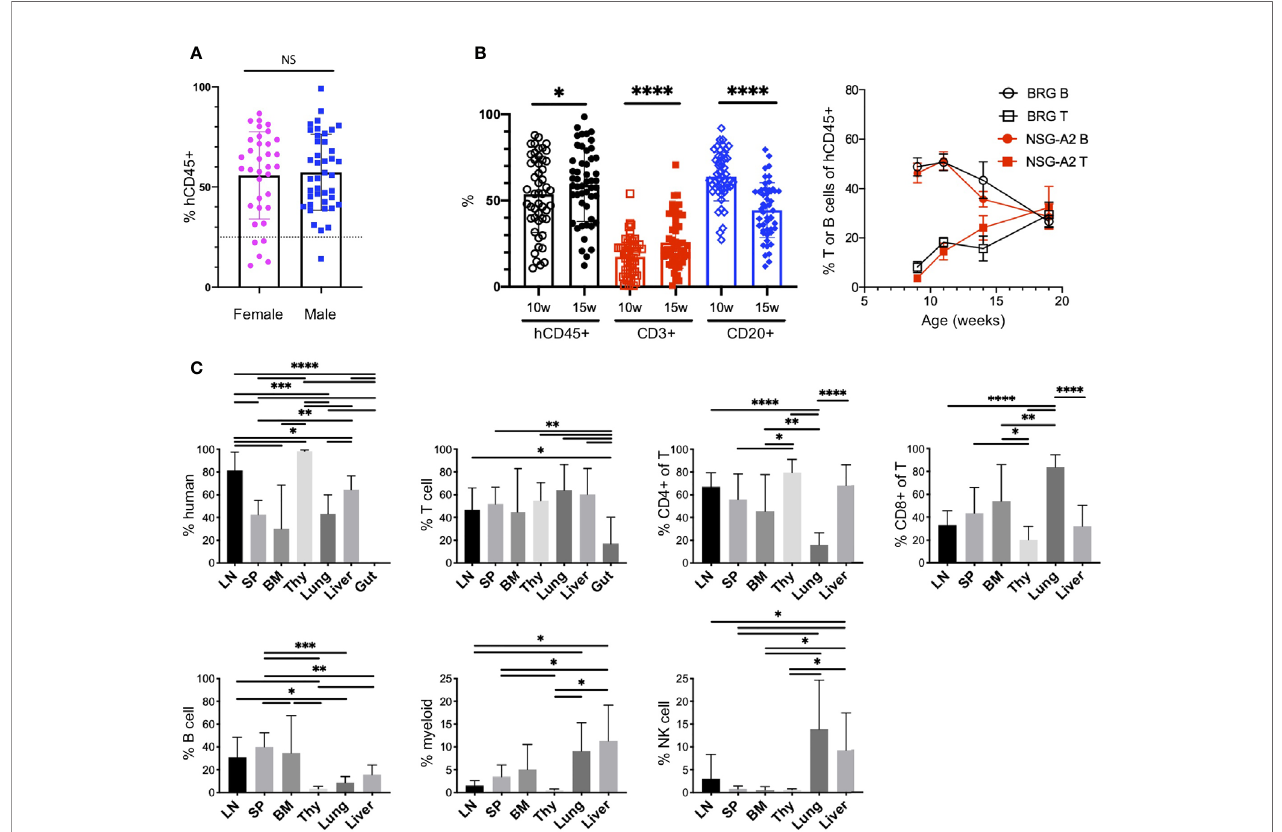
FIGURE 2 | The human immune system in HIS-BRGS-mice. (A) Human chimerism (%hCD45 of (h+m) CD45) among female (F) and male (M) HIS-BRGS mice at 10 weeks of age (n=35 F, n=41 M; two-group t-test p value = 0.74 ). (B) Percentage of human (hCD45), T cell (CD3) and B cell (CD20) subsets in PBMCs of HIS-BRGS (left panel) and BRG or NSG-A2 mice (right panel) at indicated times post engraftment. *p < 0.05 , ****p < 0.0001 [paired t-test, two-tailed]. (C) Chimerism by organ for multiple HIS-BRGS mice (n=7, except for BM CD4+/CD8+,n=6) from one CB. T cell (CD3+), B cell (CD19+), myeloid population (CD11b/33/14 or 11c+), NK cell (CD56+) populations. Gate: hCD45+ or hCD45+CD3+ (CD4+, CD8+ of T). *p < 0.05, **p < 0.01, ***p < 0.001, ****p < 0.0001 , NS, no signi fi cance. [Welch ’ s two- group t-test, two-tailed between organs as indicated by edges of each line]. LN, lymph nodes; SP, spleen; BM, bone marrow; Thy, thymus